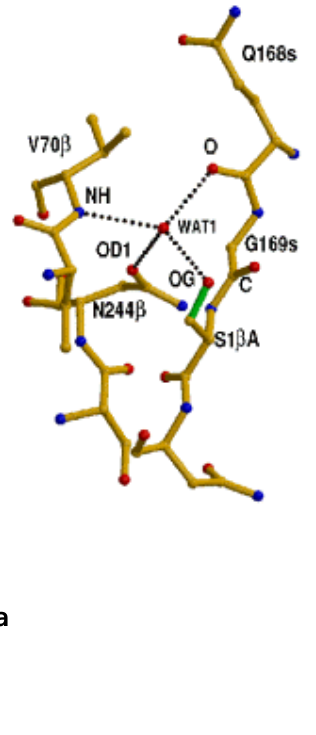
FIGURE 1 . Structure of precursor CA. The precursor structure is a single chain protein, consisting of the α subunit of active CAD in green, an orange colored P-loop (spacer structure in loop form), and the β -subunit of CAD in purple. The side-chain pocket for binding the substrate glutaryl-7- aminocephalosporanic acid is represented by a ball-and stick model in the